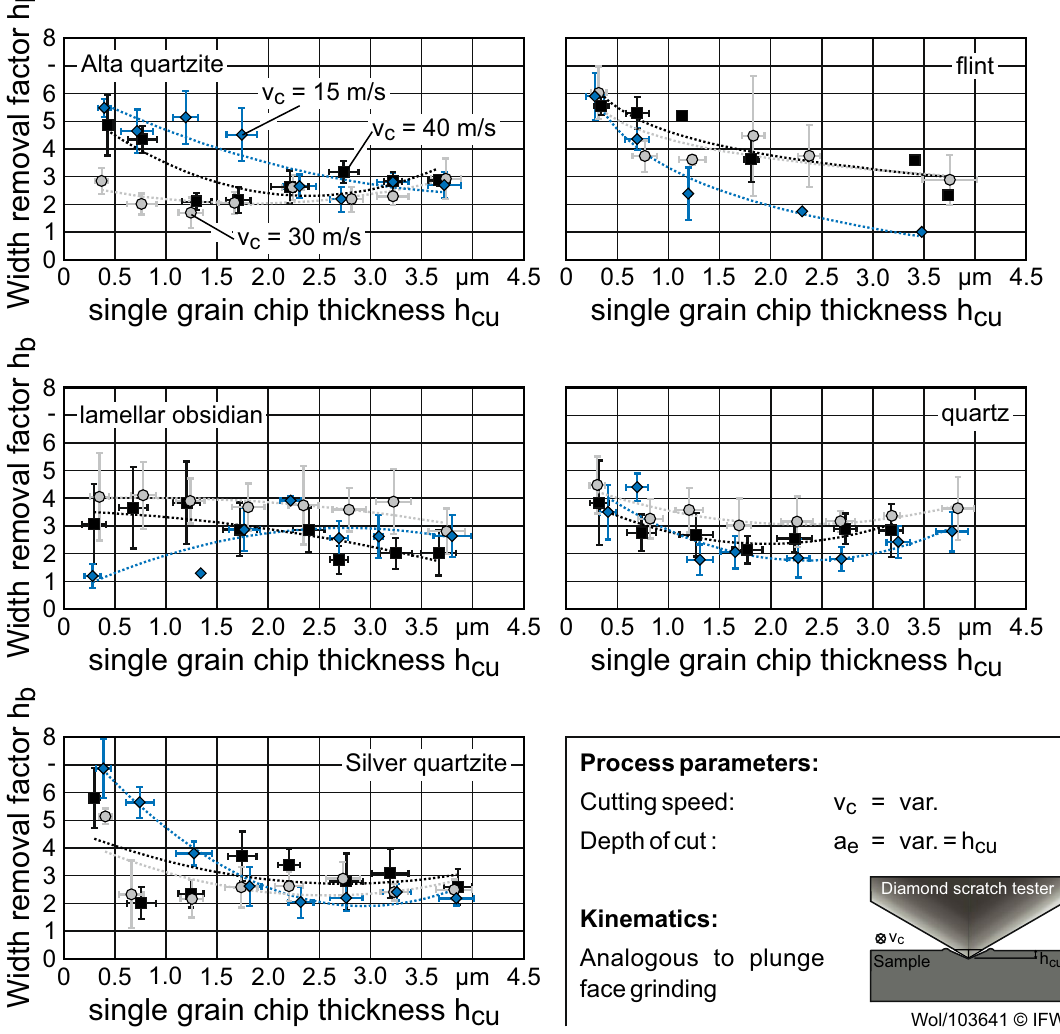
Fig. 8 Influence of cutting speed on width removal factor for all rock